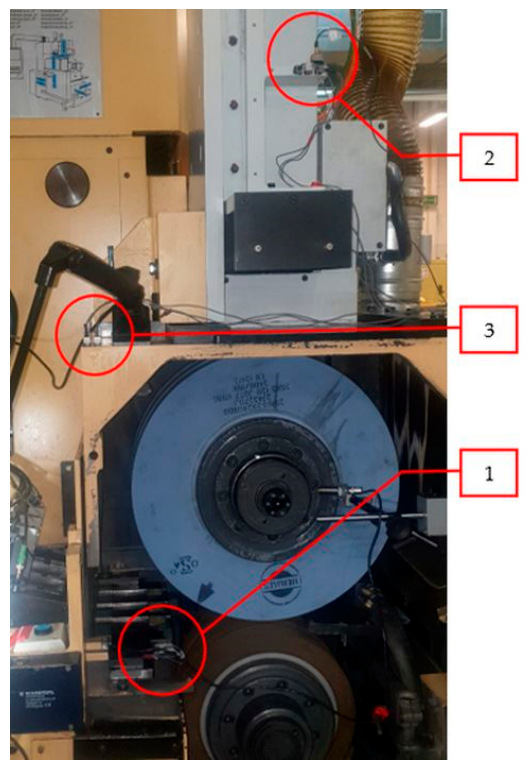
Figure 6. Location of sensors on the Nomoco VSR-5-280 machine with three locations, position 1—ruler, position 2—frame of the dressing wheel and position 3—machine frame.